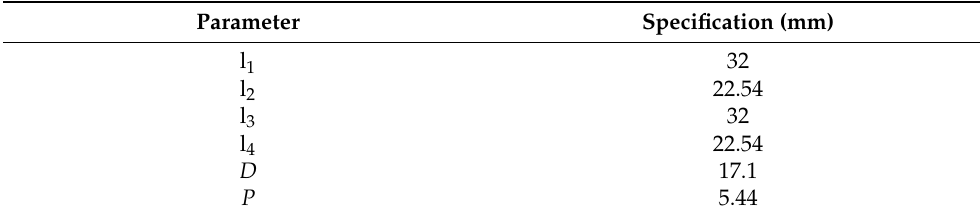
Figure 2. Design of the developed two degrees of freedom (2DoF) ankle exoskeleton robot and design of the ankle structure: ( a ) a 2DoF ankle exoskeleton robot with a polycentric structure in the talocrural joint.; ( b ) each part is responsible for the function of the ankle. Part A is the tibia, Part B is the talus, and Part C is the sole. Table 1. The parameter values of the polycentric